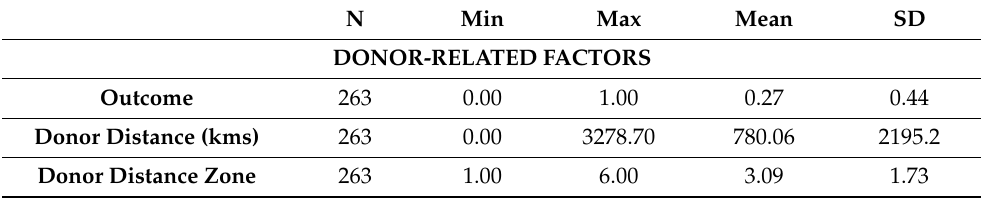
Figure 2. ( A ). Scatter plot of donor distance outcomes. Distance from Westmead (NPTU) in kilometers is shown for each analysis group, and the mean of each group is marked and labelled. Negative local ( (cid:4) n = 65), positive local ( (cid:78) n = 30), negative non-local ( (cid:72) n = 129), positive non-local ( (cid:117) n = 41), all negative ( • n = 194), all positive ( (cid:50) n = 71). ( B ) . Box plot of donor distance zone vs. CIT. The CIT is shown for each distance zone, and outliers are represented by on the graph. <50 km n = 71, 50–150 km n = 12, 151–400 km n = 9, 401–800 km n = 76, 801–1200 km n = 31, 1201–4000 n = 17. From local (zone 1) to zone 2, the mean CIT increases from 279.6 to 337.6 min which was statistically different ( p = 0.03). There was no significant difference in the mean CIT from zone 2 to zone 3 (385.1 min) ( p = 0.182), from zone 3 to zone 4 (474.8 min) ( p = 0.009) and from zone 4 to zone 5 (504.9 min) ( p = 0.171) (each zone representing a distance of 250 to 400 km). There was also a significant increase in CIT when a donor pancreas was received from zone 6 compared to zone 5 ( p = 0.109), as zone 6 represents a distance of 2800 km further than zone 5 (mean CIT 560.6 min). ( C ) . Scatter plot of CIT Outcomes. CIT in minutes is shown for each analysis group, the mean of each group is marked and labelled. Negative local ( n = 67), positive local ( n = 32), negative non- Table 1. Descriptive statistics of the data collected, grouped into donor-related factors, those that are Edmonton score donor-related factors and recipient-related factors. For non-continuous data, a number was assigned to each set of